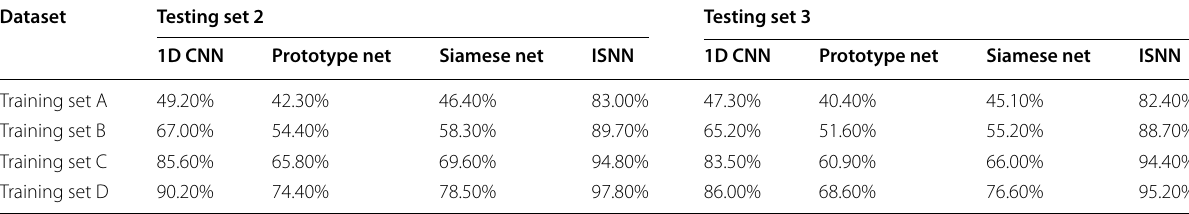
Table 6 Accuracy of various fault diagnosis methods under different testing sets